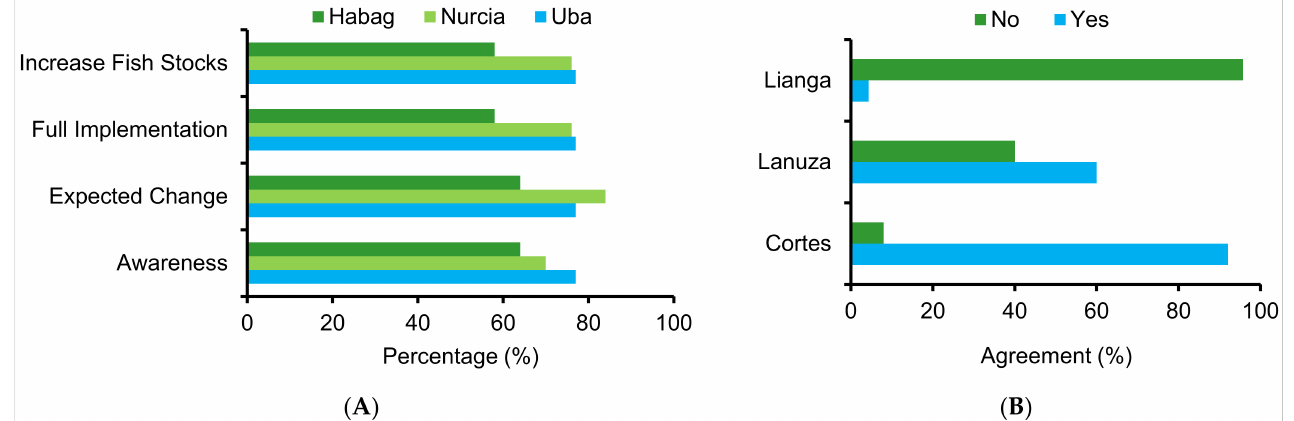
Figure 3. The percentage of awareness and agreement toward the closed season policy in the three municipalities (Cortes, Lanuza, and Lianga). Most fishers are aware of the implementation of a closed season 77% in Uba, Cortes, and 67% in Habag and Nurcia, Lanuza ( A ) while in terms of agreement for the closed season, 4% in Lianga, 60% in Lanuza and 92% in Cortes agreed to its full implementation ( B